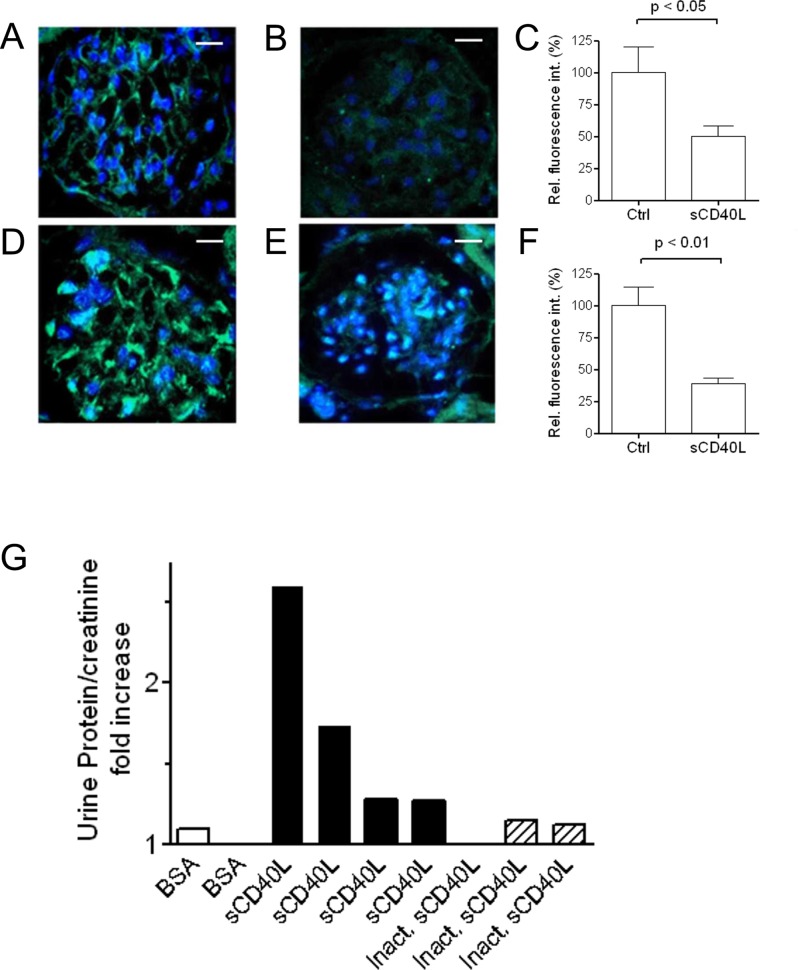
(A-F) Effect of in vivo injection of sCD40L on the glomerular expression of nephrin and podocin. (A-B) Micrographs representative of immunofluorescence staining for nephrin in glomeruli from female C57BL/6 mice injected in vivo with 200 ng sCD40L (C) or, as negative control, 200 ng heat-inactivated sCD40L (B) (x63). Bars = 10 μm. (C) Semiquantitative analysis of nephrin expression as detected by immunofluorescence staining in glomeruli from female C57BL/6 mice injected in vivo with sCD40L or, as negative control, heat-inactivated sCD40L (Ctrl). (D-E) Micrographs representative of immunofluorescence staining for podocin in glomeruli from female C57BL/6 mice injected in vivo with 200 ng sCD40L (F) or, as negative control, 200 ng heat-inactivated sCD40L (E) (x63). Bars = 10 μm. (F) Semiquantitative analysis of podocin expression as detected by immunofluorescence staining in glomeruli from female C57BL/6 mice injected in vivo with 200 ng sCD40L or, as negative control, 200 ng heat-inactivated sCD40L (Ctrl). Glomerular expression of nephrin and podocin was evaluated by indirect immunofluorescence by confocal microscopy on frozen kidney sections obtained twenty-four hours after injection, as detailed in the Methods section. Six animals were studied per experimental group. (G) Urine protein/creatinine ratio 24 hours after a single injection of 5% bovine serum albumin (BSA–white bars), sCD40L (black bars), or heat-inactivated sCD40L (dashed bars) in female C57BL/6 mice. Each bar is representative of a single experiment.